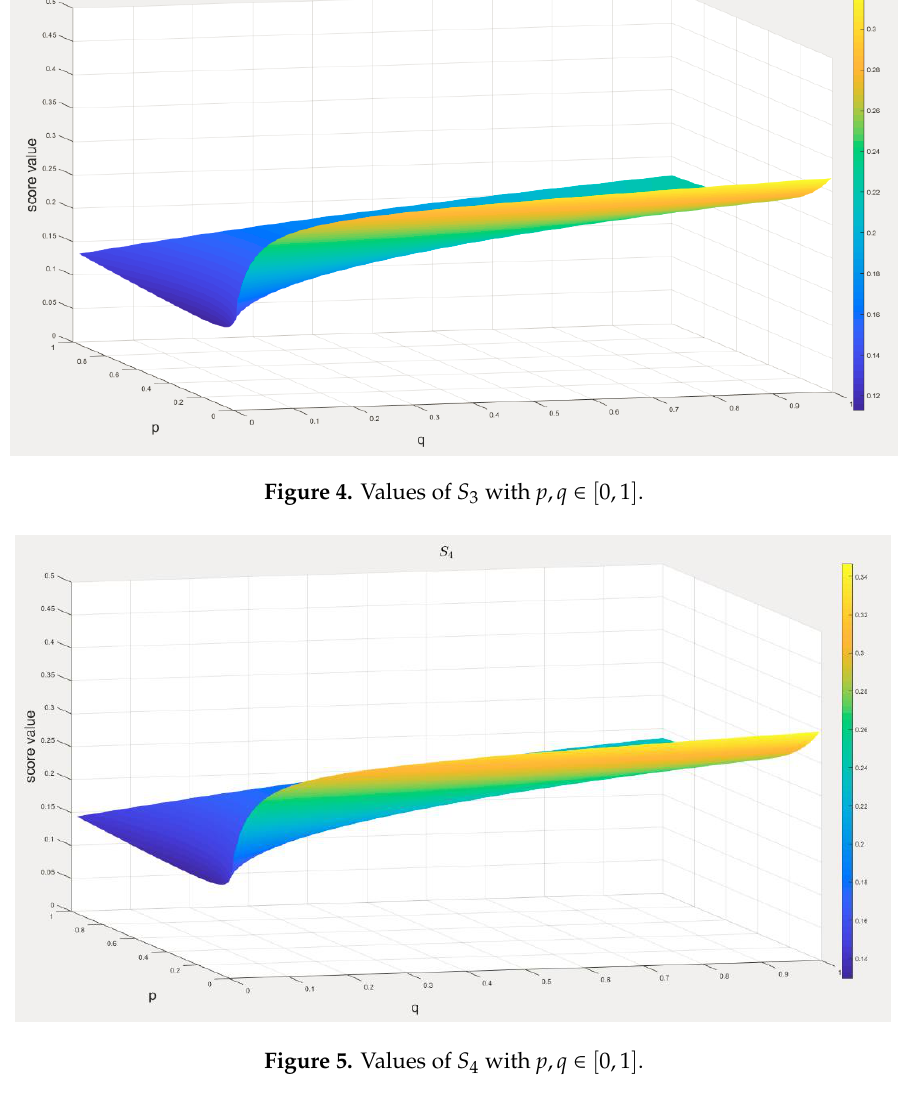
Figure 5. Values of S 4 with p , q ∈ [ 0,1 ] .